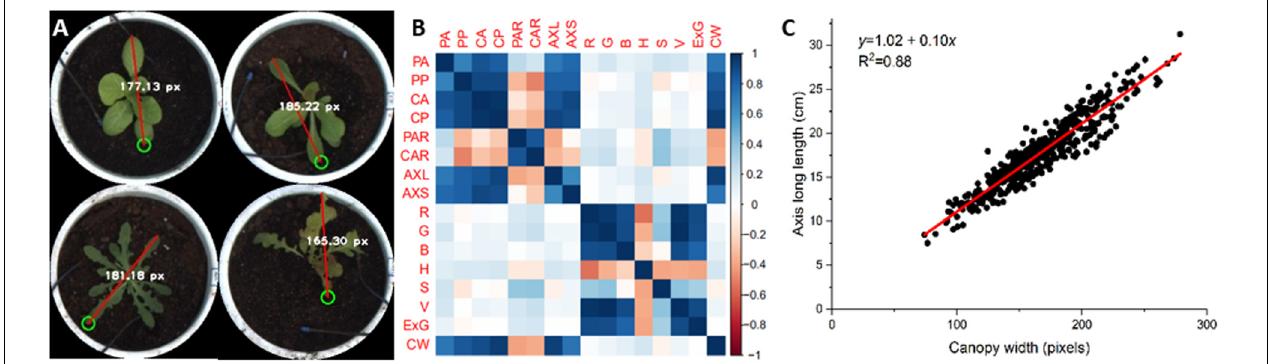
FIGURE 8 | Canopy width (CW) as assessed by interactive measurement and correlation analysis with static traits of lettuce plants. (A) CW as assessed by interactive measurement. (B) Correlation between canopy width and static traits of lettuce. (C) Linear fit of canopy width and long axis length (AXL).